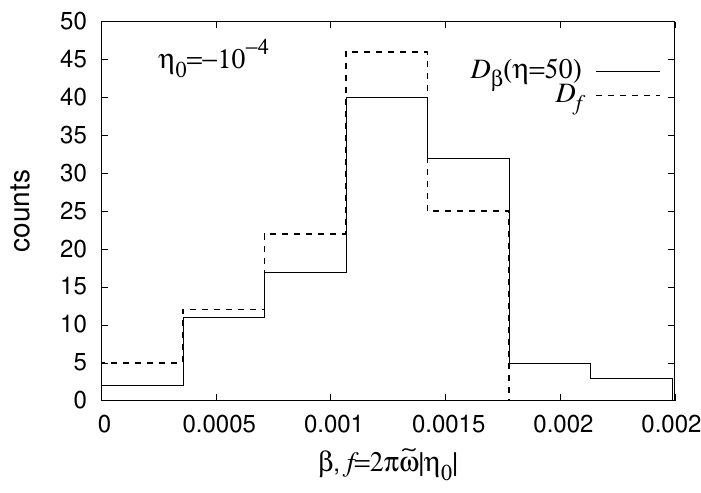
Figure 3 . Binned distributions of the thermal parameter (cid:12) ‘ , corresponding to the Williamson normal modes of a subsystem at time (cid:17) = 50, and the parameter f ‘ computed from the subsystem’s normal frequencies ! ‘ as shown; (cid:17) 0 = (cid:0) 10 (cid:0) 4 . The results are for a massless scalar in two spatial e dimensions, for a subsystem de(cid:12)ned as a 10 (cid:2) 11 rectangle in the middle of a 31 (cid:2) 33 square